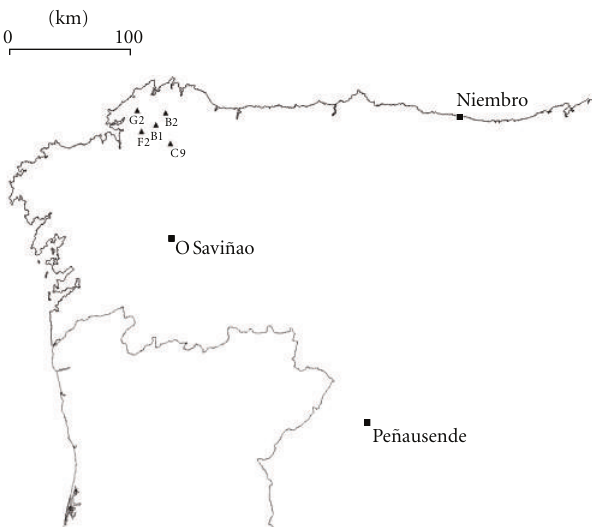
Figure 2: Map of the monitoring sites in NW Iberian Peninsula. Table 2: Air quality stations whose data have been used for comparative purposes in this study. The coordinates are Universal Transverse Mercator (UTM) and grid zone 29T, except Pe˜nausende and Niembro stations, in grid zone 30T. Station UTMx (km) UTMy (km) Distance to the sea (km) Altitude (m) Monitoring network ES16-O Savi˜nao 606.1 4721.2 88.1 506 EMEP ES08-Niembro 350.3 4811.7 0.0 134 EMEP ES13-Pe˜nausende 259.9 4574.3 238.0 985 EMEP B1-A Magdalena 593.3 4811.4 28.0 363 Regional B2-Louseiras 601.8 4821.1 18.0 540 Regional C9-Mourence 606.0 4796.4 41.0 465 Regional F2-Fraga Redonda 581.9 4806.3 16.0 480 Regional G2-Vilanova 578.5 4822.9 11.0 290